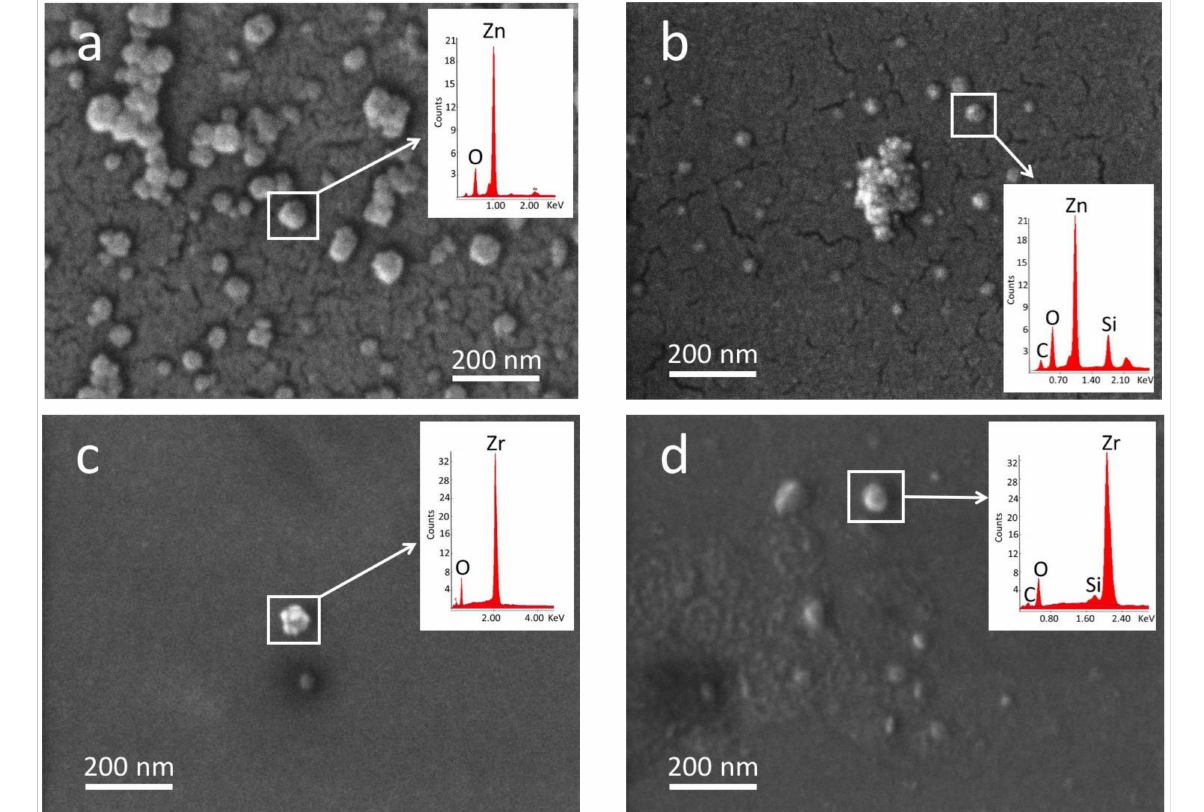
Figure 2. Scanning electron microscopy (SEM) micrographs of investigated NPs and GPTMS-capped NPs: ( a ) ZnO; ( b ) ZnO- ES; ( c ) ZrO 2 ; ( d ) ZrO 2 -ES. Corresponding EDS spectra are in the insets; Au peaks (2.1–2.2 KeV) in the spectra are due to gold sputtering of the